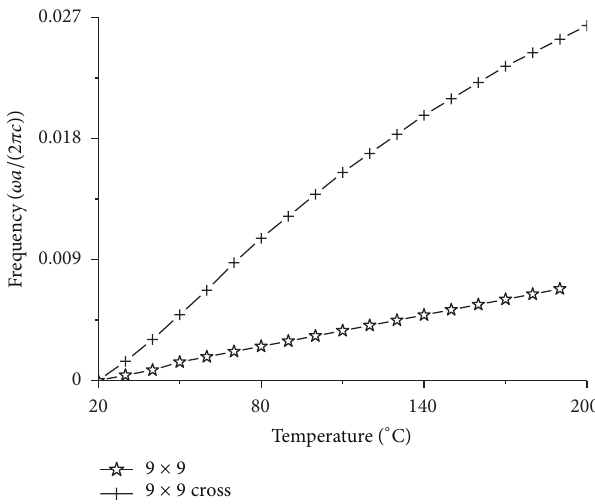
Figure 11: The parallel moved temperature curves with the biggest average normalized power spectrum for the 9×9 cavity and the 9×9 cavity with a cross structure in the center.